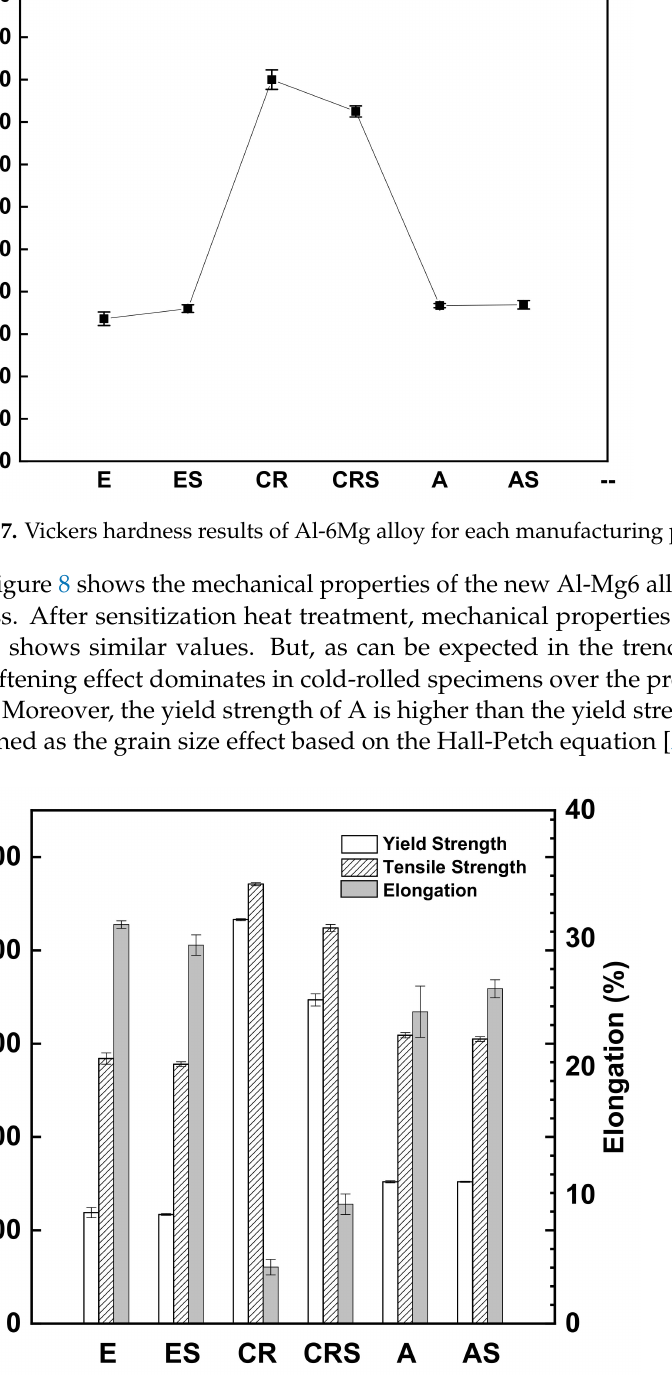
Figure 8. Mechanical properties of Al-6Mg alloy with each manufacturing